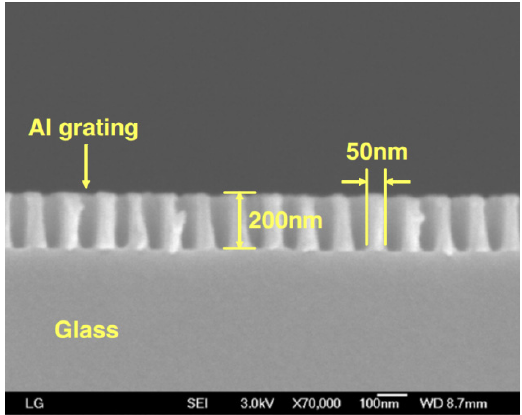
Figure 37. SEM image of an aluminum grating.